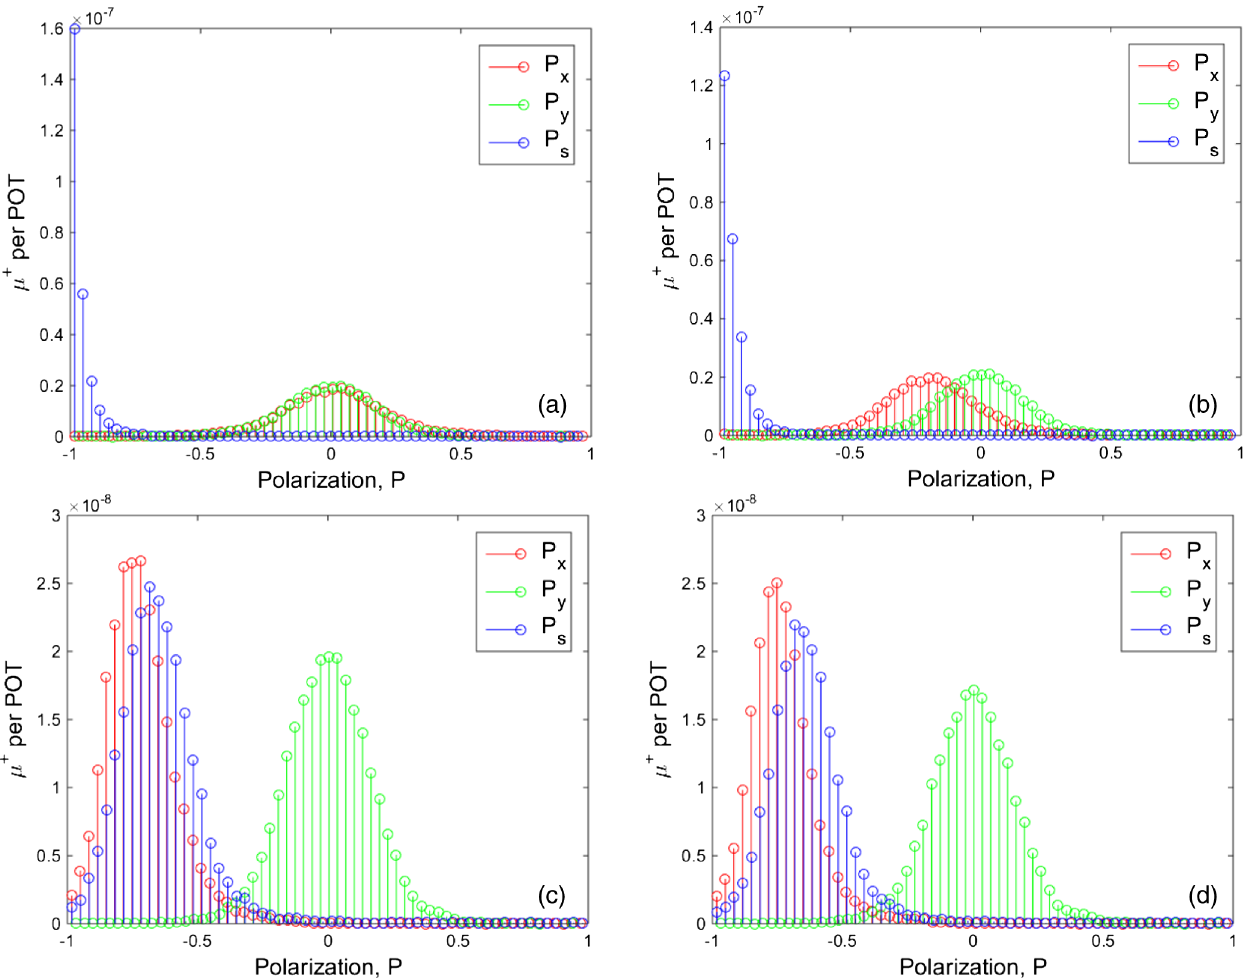
FIG. 9. The simulation results for the muon horizontal (P (b) after one turn in the DR, (c) after four turns in the DR, and (d) at end of the M5-line. The average muon beam polarization is ∼ 96 % and remains unchanged through the